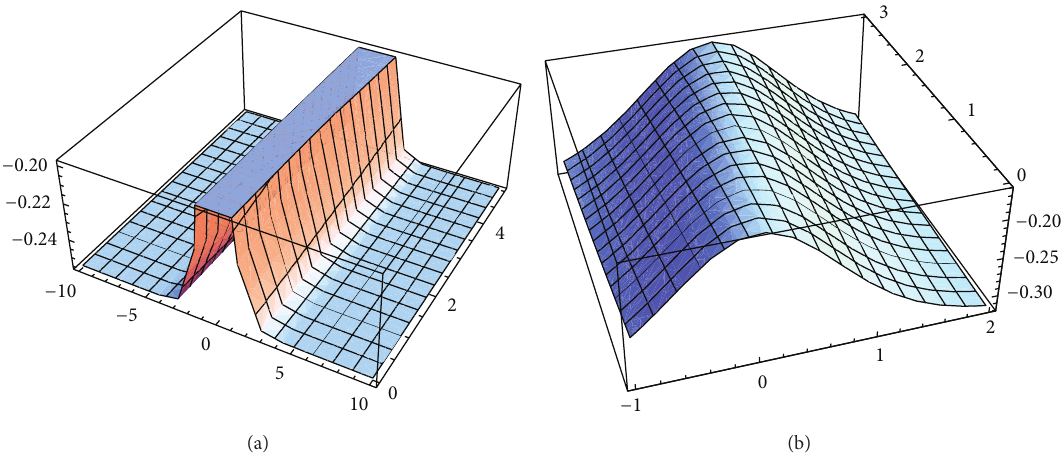
Figure 4: Travelling waves solutions (40) are plotted: bright solitary